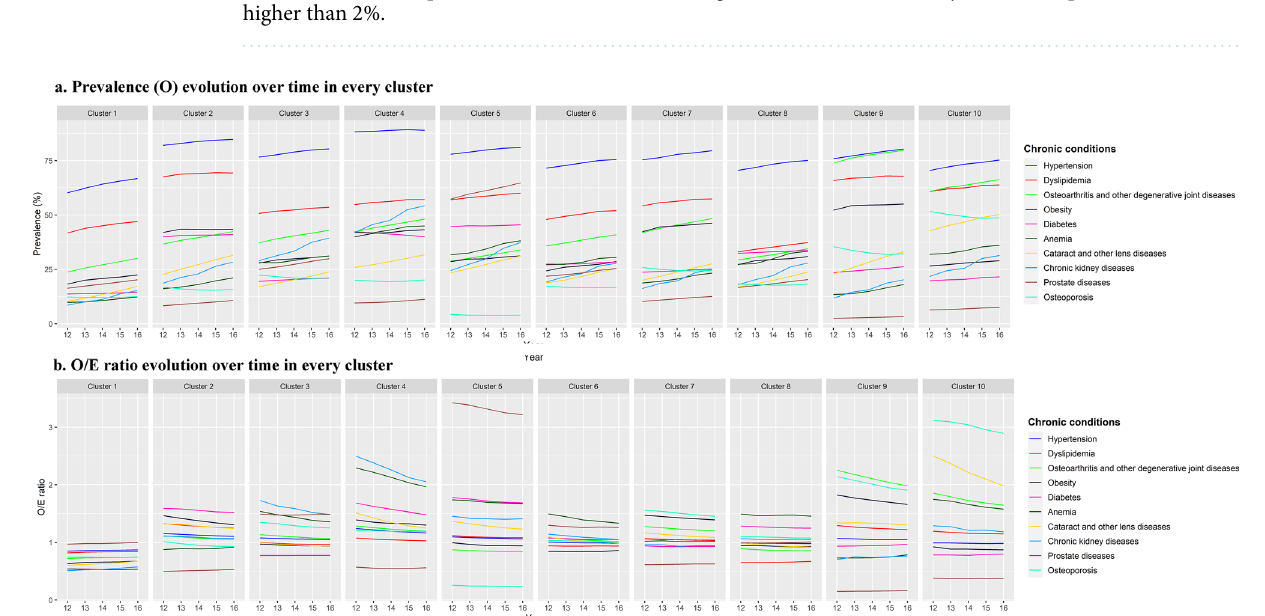
Figure 4 also shows the transition between baseline and final clusters. The proportion of sample remains stable for each baseline pattern, except for the C1-Non-Specific pattern, which shows a decrease from 42 to 28%. The study of the mortality showed that C4-Cardio-Circulatory and Renal; C5 Cardio-Circulatory, Mental, Respiratory and Genitourinary; C6-Nervous, Digestive and Circulatory; and C8-Digestive presented the highest hazard of death after adjusting for confounders (adjusted HRs over 1.5) (Table 2).